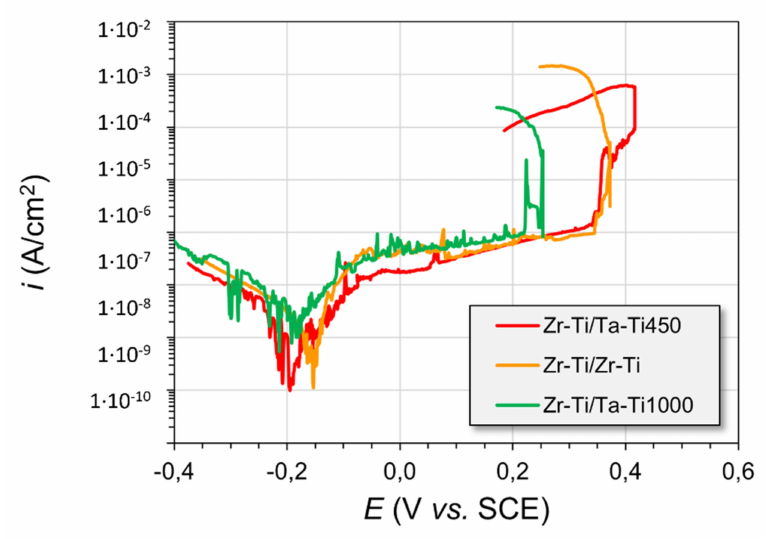
Figure 10. Potentiodynamic polarization (PDP) curves, recorded for the metal samples after EOCP stabilization in Ringer’s